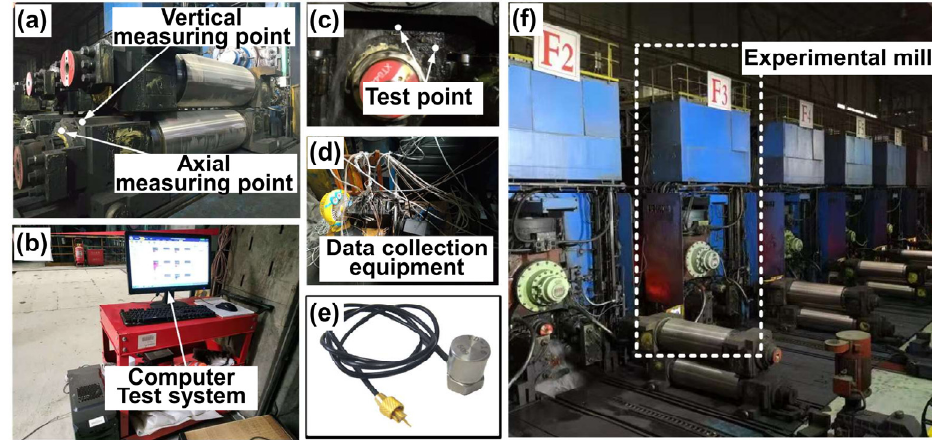
Figure 12. Engineering experiment test platform: ( a ) the RBBH system, ( b ) test instrument, ( c ) test point, ( d ) test system, ( e ) piezoelectric acceleration sensor, and ( f ) experimental rolling mill.